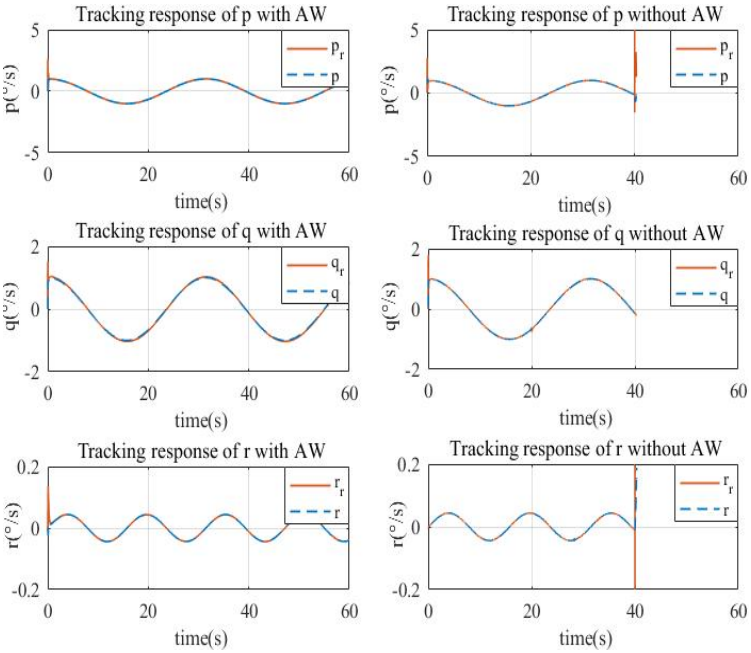
Figure 12. Tracking response of p , q and r .